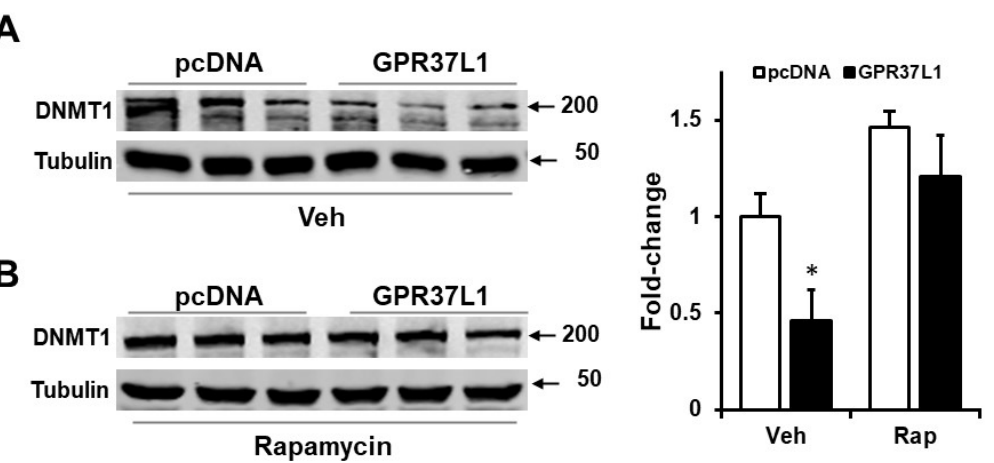
Figure 8. GPR37L1 decreases DNMT1 expression through mTOR. The hRPTCs, transfected with GPR37l1 or control plasmid (pcDNA), were treated with vehicle (Veh) or rapamycin (50 nM [Rap], for 24 h). ( A , B ) Protein preparations from the hRPTCs were immunoblotted for DNMT1. Quantification of DNMT1 expression normalized by tubulin. n = 3/group, * p < 0.05 vs. pcDNA+Veh, t -test.